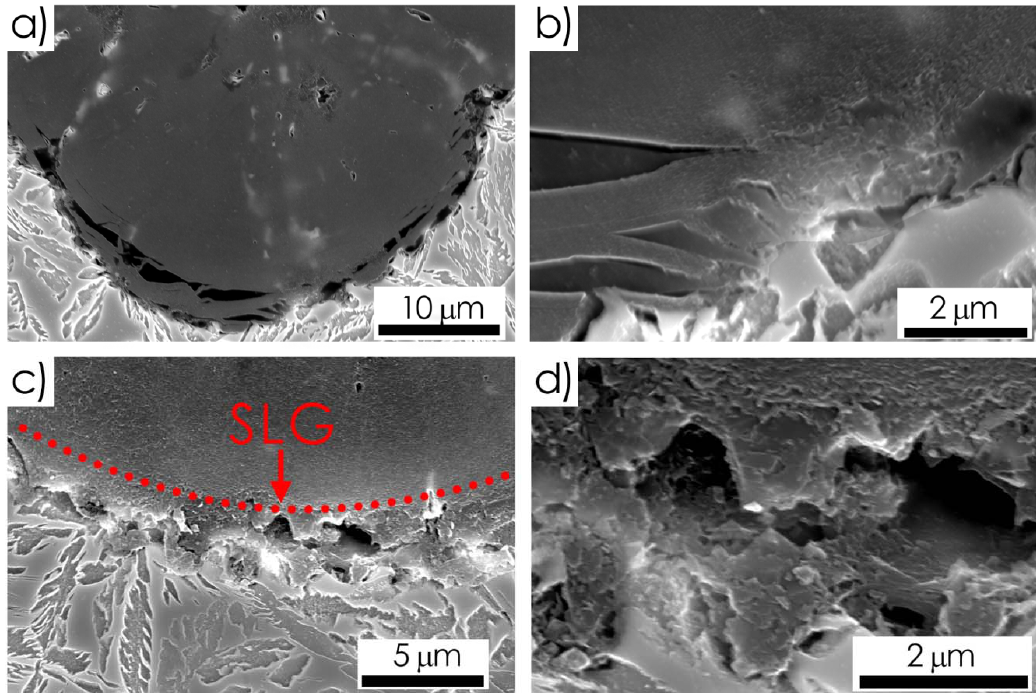
Figure 16. Morphology of the G ‐ M interface in a spheroid near the fracture surface, (ADI cyclic specimen), SEM: ( a ) Secondary layer around the primary spheroid, separated with peripheral crack in pole area, (b) enlarged area of ( a ), ( c ) a peripheral crack between primary core and secondary layer of graphite (SLG), ( d ) shift of basal plates in secondary layer, enlarged area of ( c ).